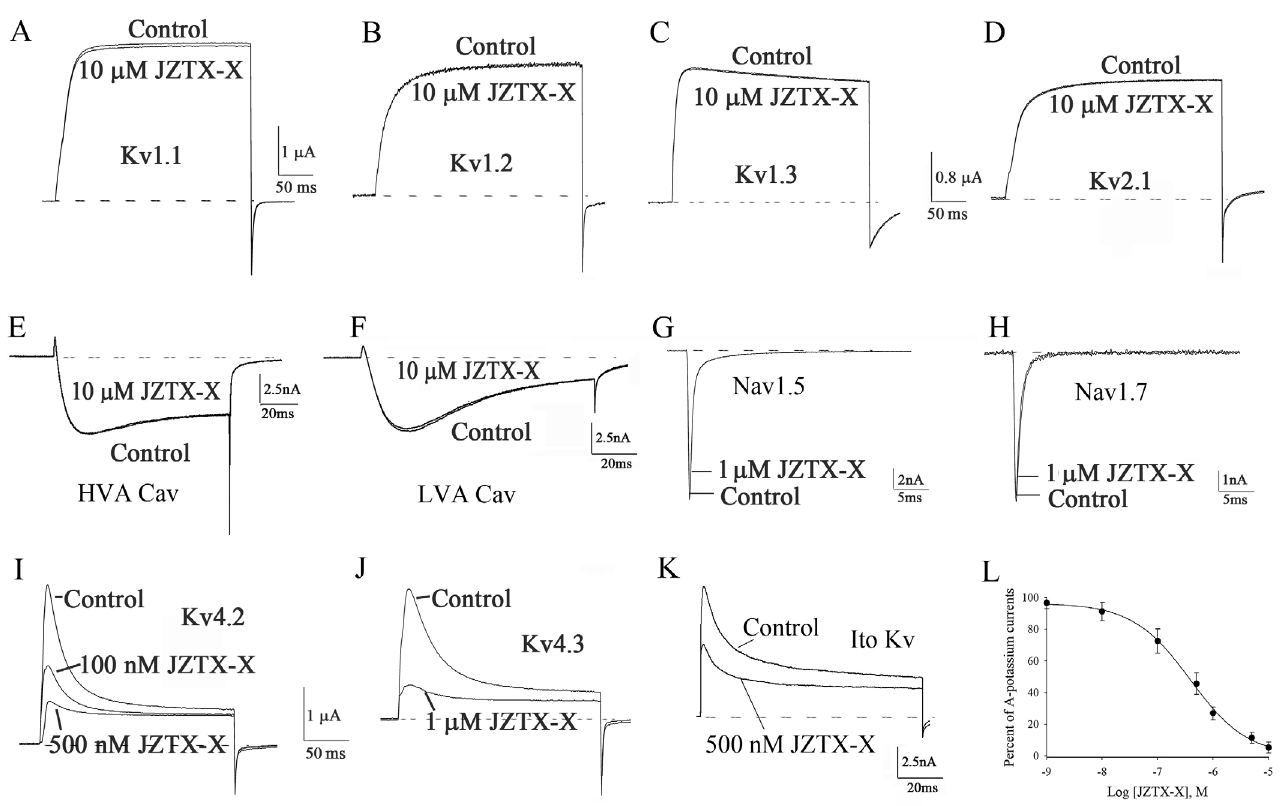
Figure 3. Effects of JZTX-X on the voltage-gated potassium channels in X. laevis oocytes: (A-D) 10 μM JZTX-X did not markedly affect the currents of the isoforms of delayed rectifier potassium channels Kv1.1 (A), Kv1.2 (B), Kv1.3 (C), or Kv2.1 (D) channels. 300-ms depolarization was applied to elicit the potassium currents to +20 mV from the –90 mV holding potential (Vh). (E-F) 10 μM JZTX-X apparently did not affect the currents of HVA Cav channels (E) or LVA Cav channels (F) from rat DRG neurons. (G-H) One μM JZTX-X did not affect the currents of Nav1.5 (G) or Nav1.7 channels (H). (I) 100 nM and 500 nM JZTX-X inhibited 57.8±4.6% and 83.8±5.1% of Kv4.2 currents, respectively. (J) 1 μM JZTX-X inhibited 72.4±4.8% of Kv4.3 currents. (K) 500 nM JZTX-X inhibited 54.4 ± 6.8% of Ito currents in rat DRG neurons. ( L ) Concentration-dependent inhibition of Ito channels by JZTX-X in rat DRG